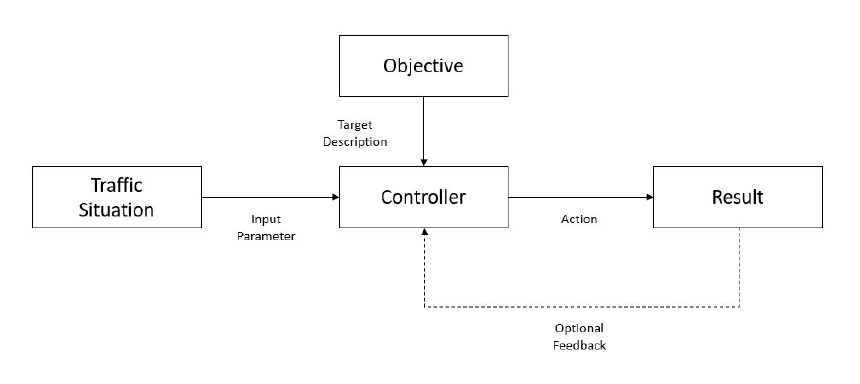
Figure 2. Congestion control mechanism from a control theory point of view